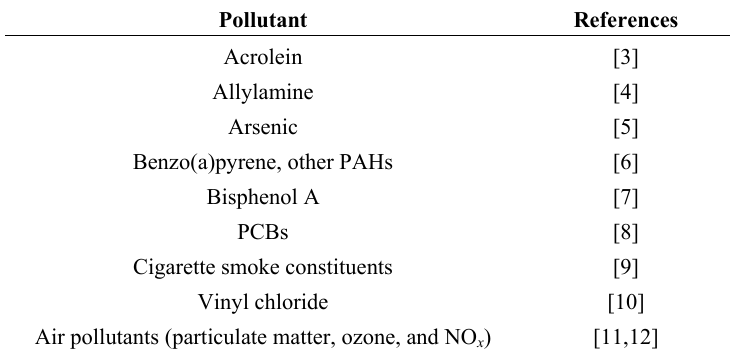
Table 1. Exogenous chemicals/pollutants associated with atherosclerosis development.